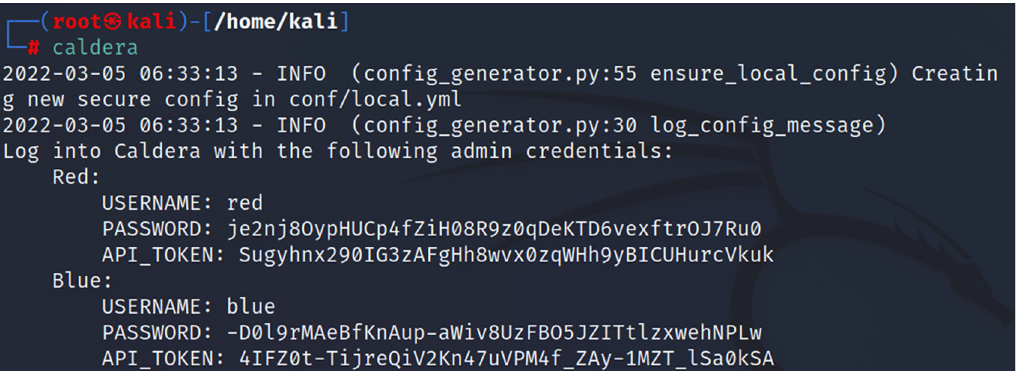
Figure 4. Running